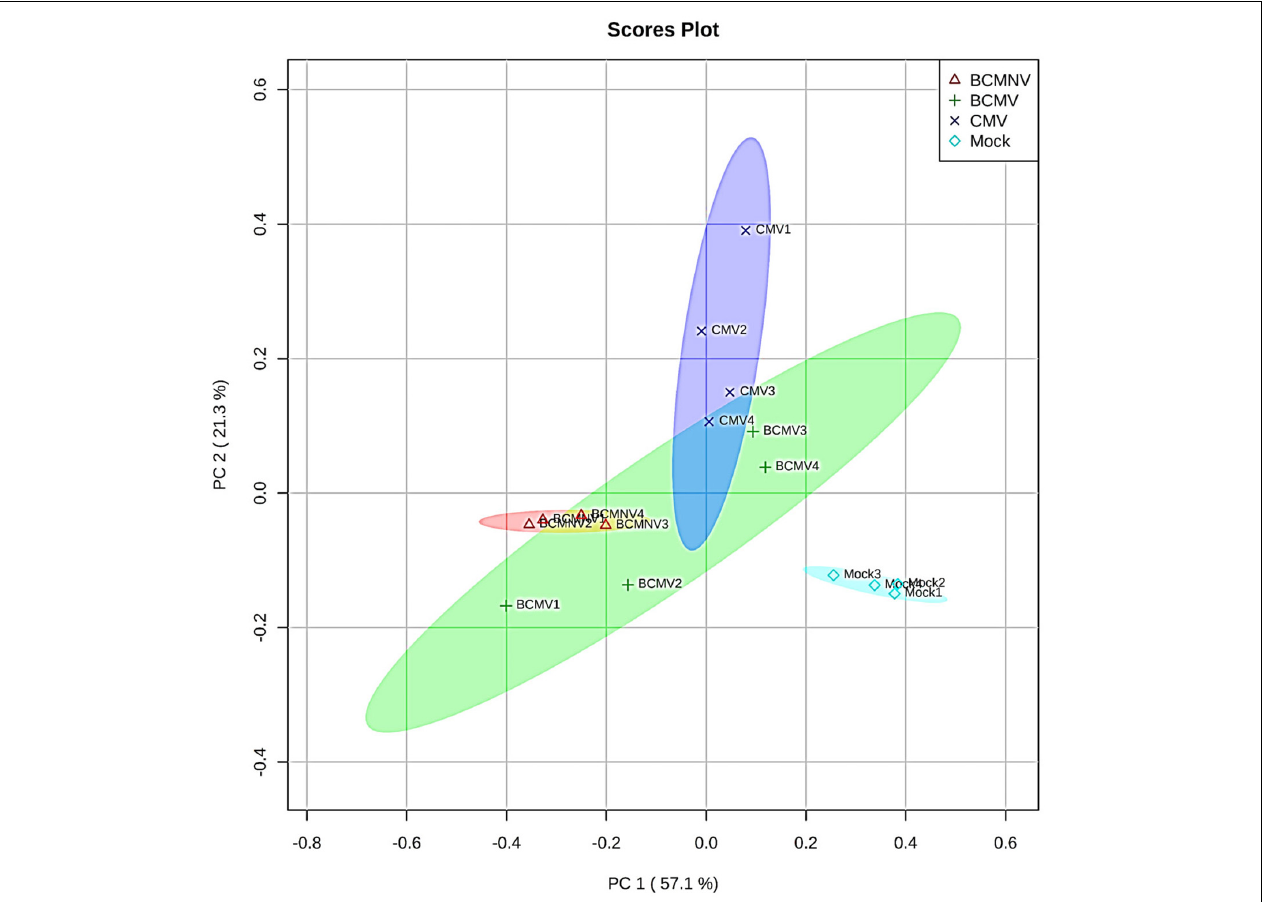
FIGURE 2 | Principal component analysis (PCA) of mass spectrometry data shows qualitative differences in volatile organic compound (VOC) blends. A score scatter plot of PCA of the m/z values (binned to 1.0 Da) obtained by gas chromatography-mass spectrometry of samples of VOCs collected by dynamic headspace trapping from bean plants. Samples collected from four plants in each treatment group; mock-inoculated (light blue color) BCMV (green), BCMNV (pink), and CMV (dark blue) infected plants were compared. The analysis showed discrimination between mock-inoculated and virus-infected plants and revealed an overlap between the principal ions representing the VOC blends from the virus treatments. The percentage of variation of the data explained by PC1 and PC2 is in parentheses (57.1 and 21.3%,